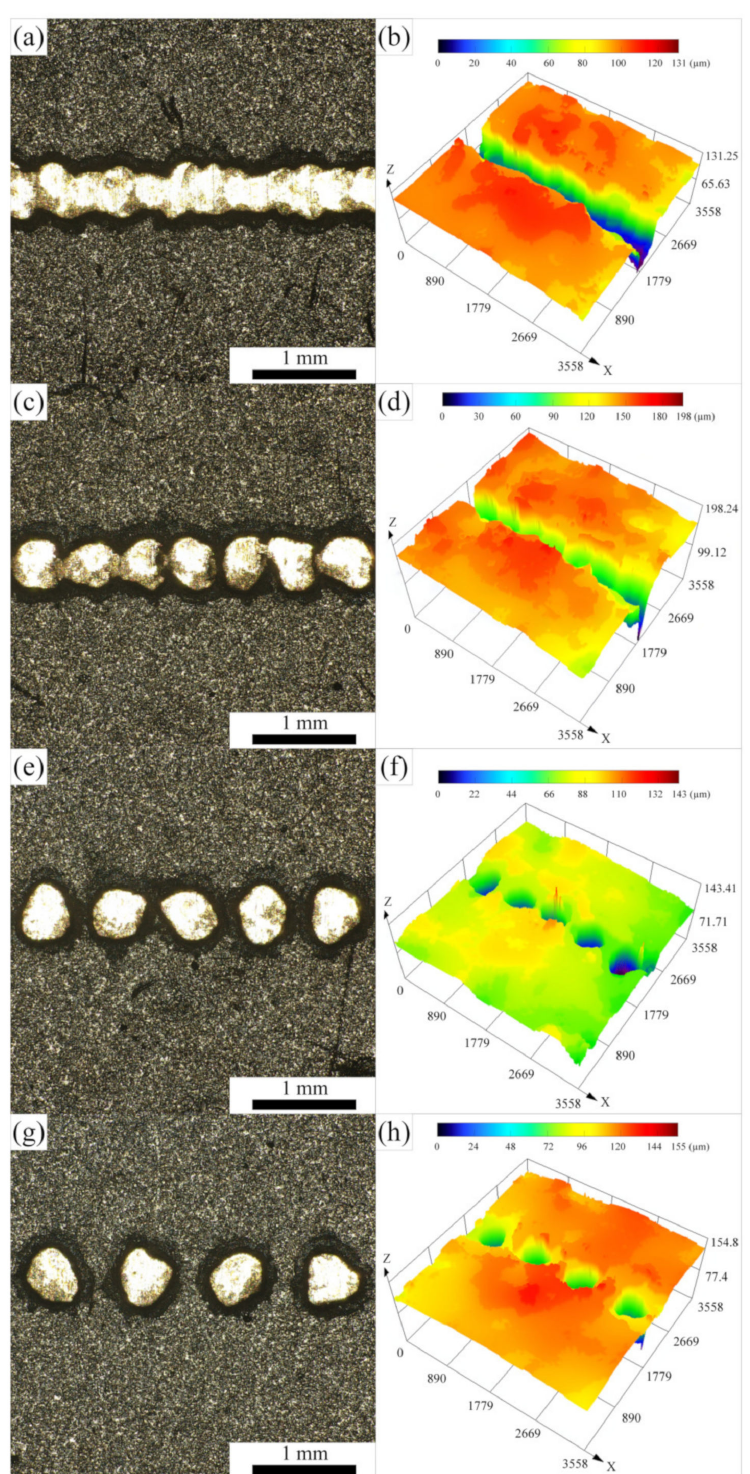
Figure 9. Effect of cleaning speed of water jet-guided laser on surface morphology of samples. ( a ) 150 mm/s; ( b ) 150 mm/s; ( c ) 300 mm/s; ( d ) 300 mm/s; ( e ) 450 mm/s; ( f ) 450 mm/s; ( g ) 600 mm/s; ( h ) 600